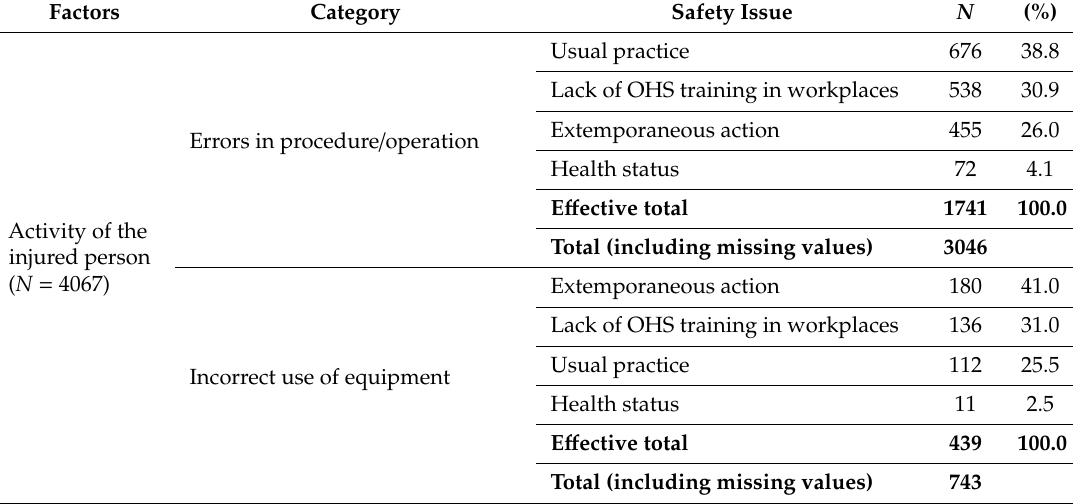
Table 6. Factors contributing to fatal work accidents by category and safety issues. Number (N); column percentage